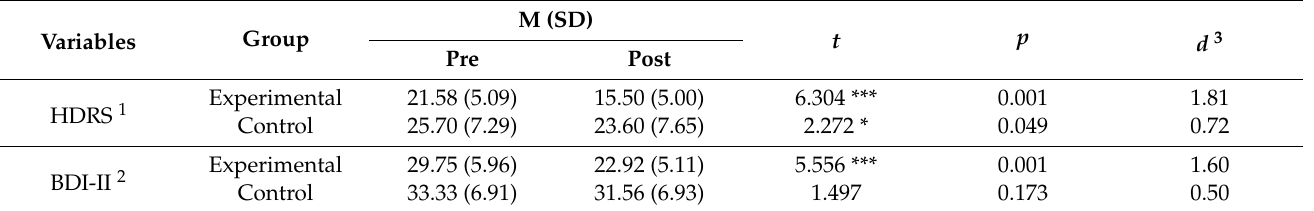
Table 2. Comparison of measurements between the experimental and control groups in moderate-to- severe